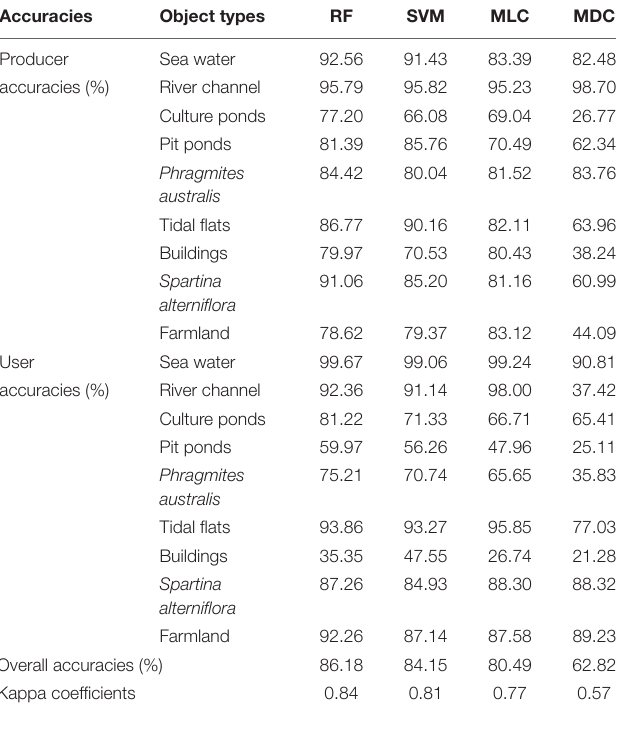
MLC took about 8 min under the same conditions. Therefore, considering time efficiency and overall classification accuracy, RF classification performed best.